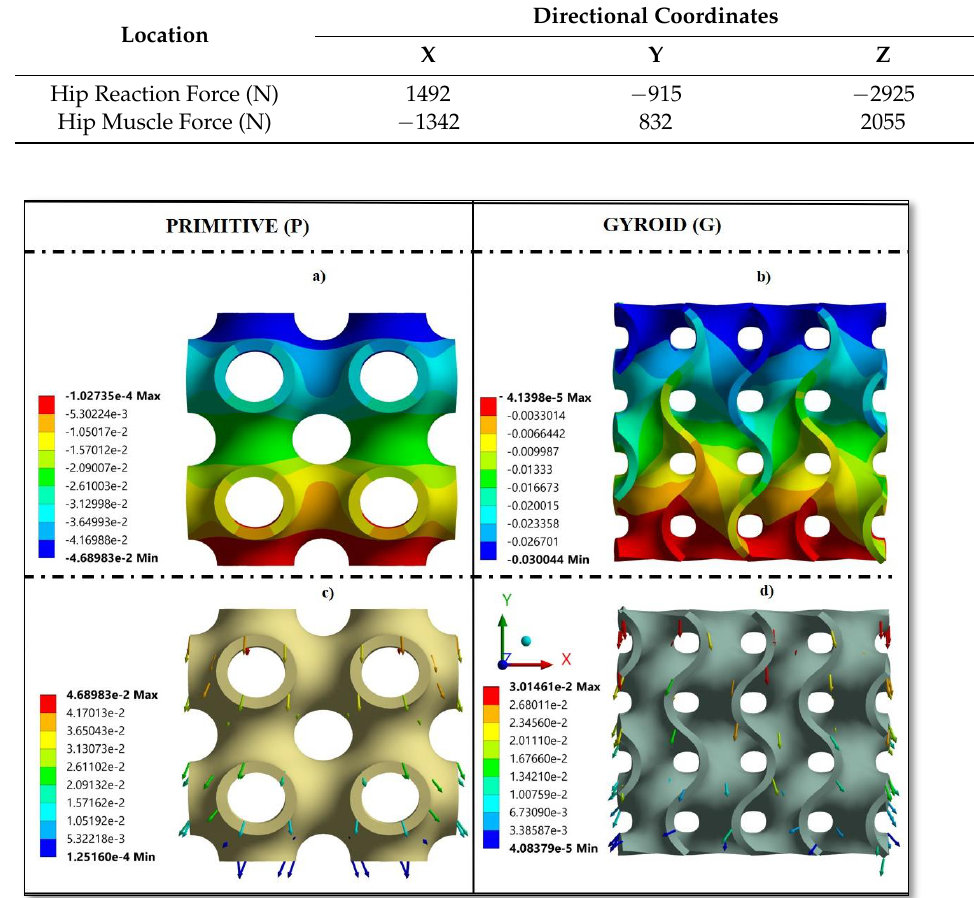
Table A3. Applied Loads on the model.